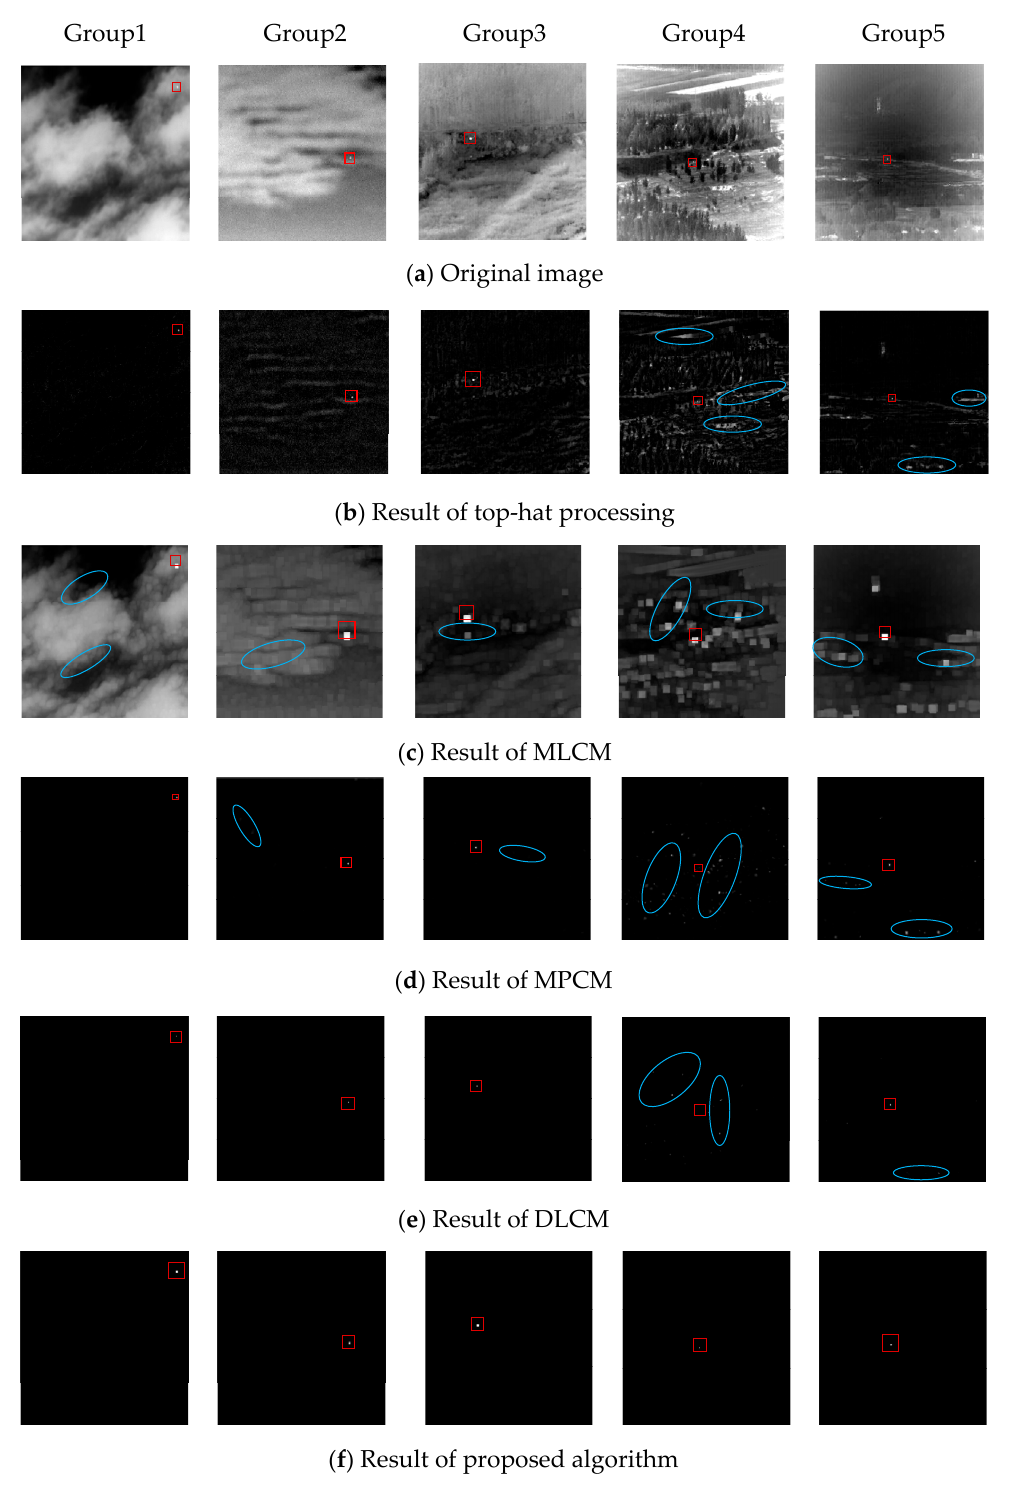
Figure 5. ( a ) Original image; ( b ) result after top-hat processing; ( c ) result after MLCM processing; ( d ) result after MPCM processing; ( e ) result after DLCM processing; ( f ) result after algorithm pro- cessing in this paper. Red squares and blue circles represent targets and clutter respectively. Table 1. Five sets of infrared image sequence dataset parameters.